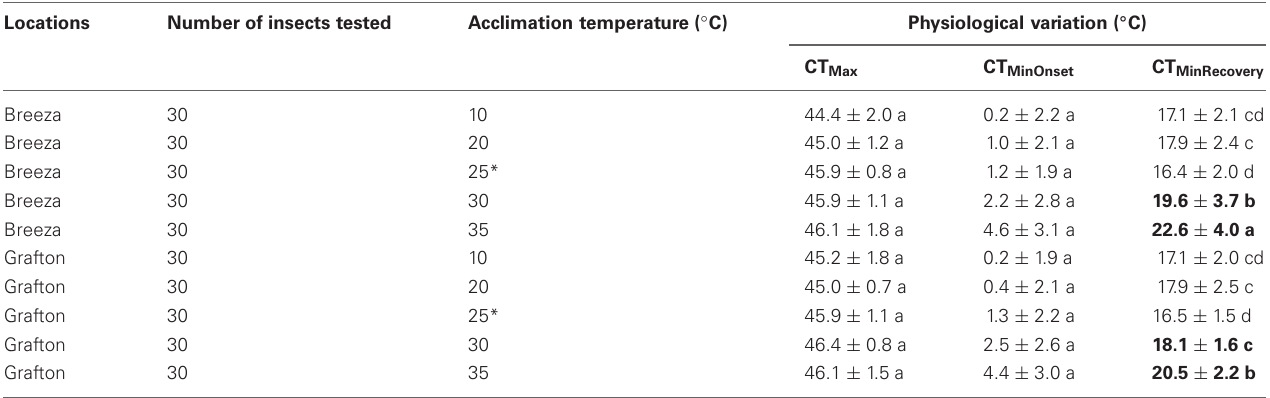
Table 2 | Interactions of location and physiological variation of Nezara viridula (L.) in culture room and laboratory temperature acclimated. Locations